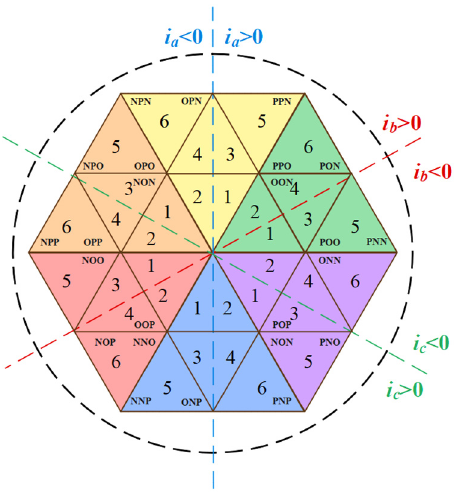
Figure 5. Ideal and actual voltage vector comparison. According to the phase relationship in Figure 4, the θ expression can be obtained, where ω is the angular frequency of the AC power supply. L (1) There are six zero-crossing distortion regions in one cycle, and the distribution is shown in Figure 6. The replacement of redundant vectors is shown in Table 1. Figure 6. Vienna rectifier Zero-Crossing Distortion Sector Diagram.